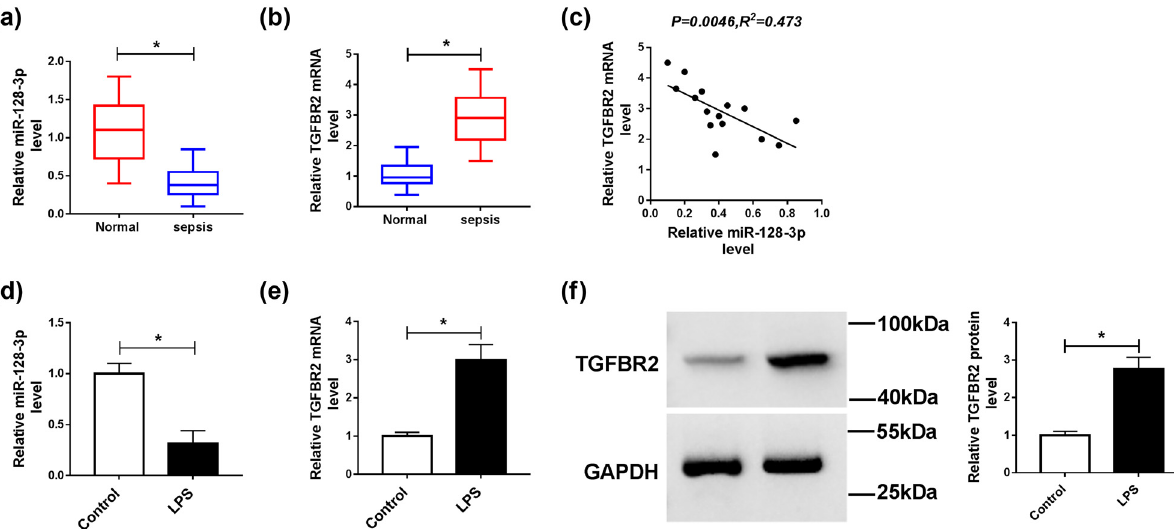
Figure 1: Expression levels of miR - 128 - 3p and TGFBR2 in serum samples of sepsis patients and LPS - induced HK2 cells. ( a and b ) The expression levels of miR - 128 - 3p and TGFBR2 were measured in serum samples of patients with sepsis and control groups by qPCR. ( c ) The association between TGFBR2 mRNA level and miR - 128 - 3p abundance was measured in serum samples of patients with sepsis. ( d and e ) The expression levels of miR - 128 - 3p and TGFBR2 were detected in LPS - induced HK2 cells by qPCR. ( f ) Western blot was performed to detect the protein level of TGFBR2. * P <